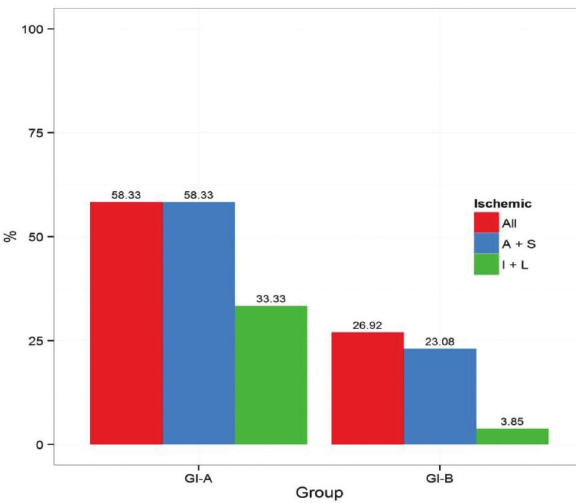
Figure 1 - Myocardial perfusion abnormalities were more prevalent in GI-A than in GI-B ( p =0.03), and 82 Rb-PET myocardial perfusion could discriminate between the groups in all LV territories. All of the values are expressed in terms of the number of patients. A = anterior; S = septal; I = inferior; L = lateral. prognostic values of MBF and CFR using 82 Rb-PET, beyond relative myocardial perfusion image interpretation, has already been established. Worse patient outcomes and a higher incidence of cardiac events (death and myocardial infarction) have been demonstrated in cases with global CFR o 2 mL/min/g in patients with normal and abnormal relative myocardial perfusion (24,25). Despite the low prevalence of LBBB in the general population (26), several studies have reported its frequent association with heart disease. In the Framingham study, CAD was found in 40% of LBBB patients and was associated with a fourfold increase in the risk of cardiovascular mortality (27).